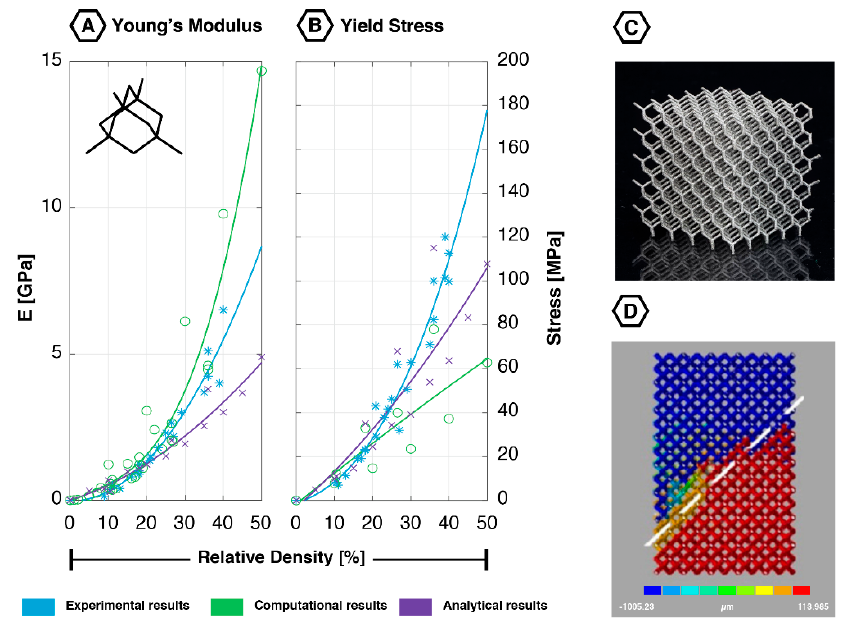
Figure 1. Mechanical properties of the diamond unit cell based on experimental, computational, and analytical data: ( A ) Young’s modulus [18,19,21,33–42]; ( B ) yield stress [18,19,21,33,34,36–38,40]; ( C ) additively manufactured diamond lattice (5 × 5 × 5 unit cells); ( D ) fatigue failure surface (45-degree shear band) showing the deformation in the loading direction; reprinted with permission from Ref. [20] © 2016